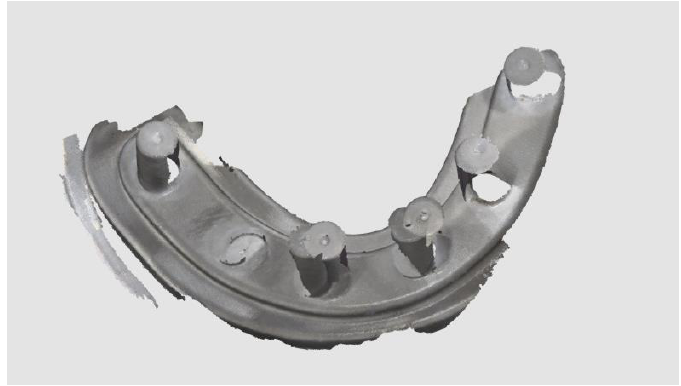
Figure 12. Incorrect stitching process experienced during digital impression of the six-implant impression without the prosthetic template. Table 1. Mean angular deviation between groups. Data are presented in degrees (°) as the mean ± SD (95% CI).